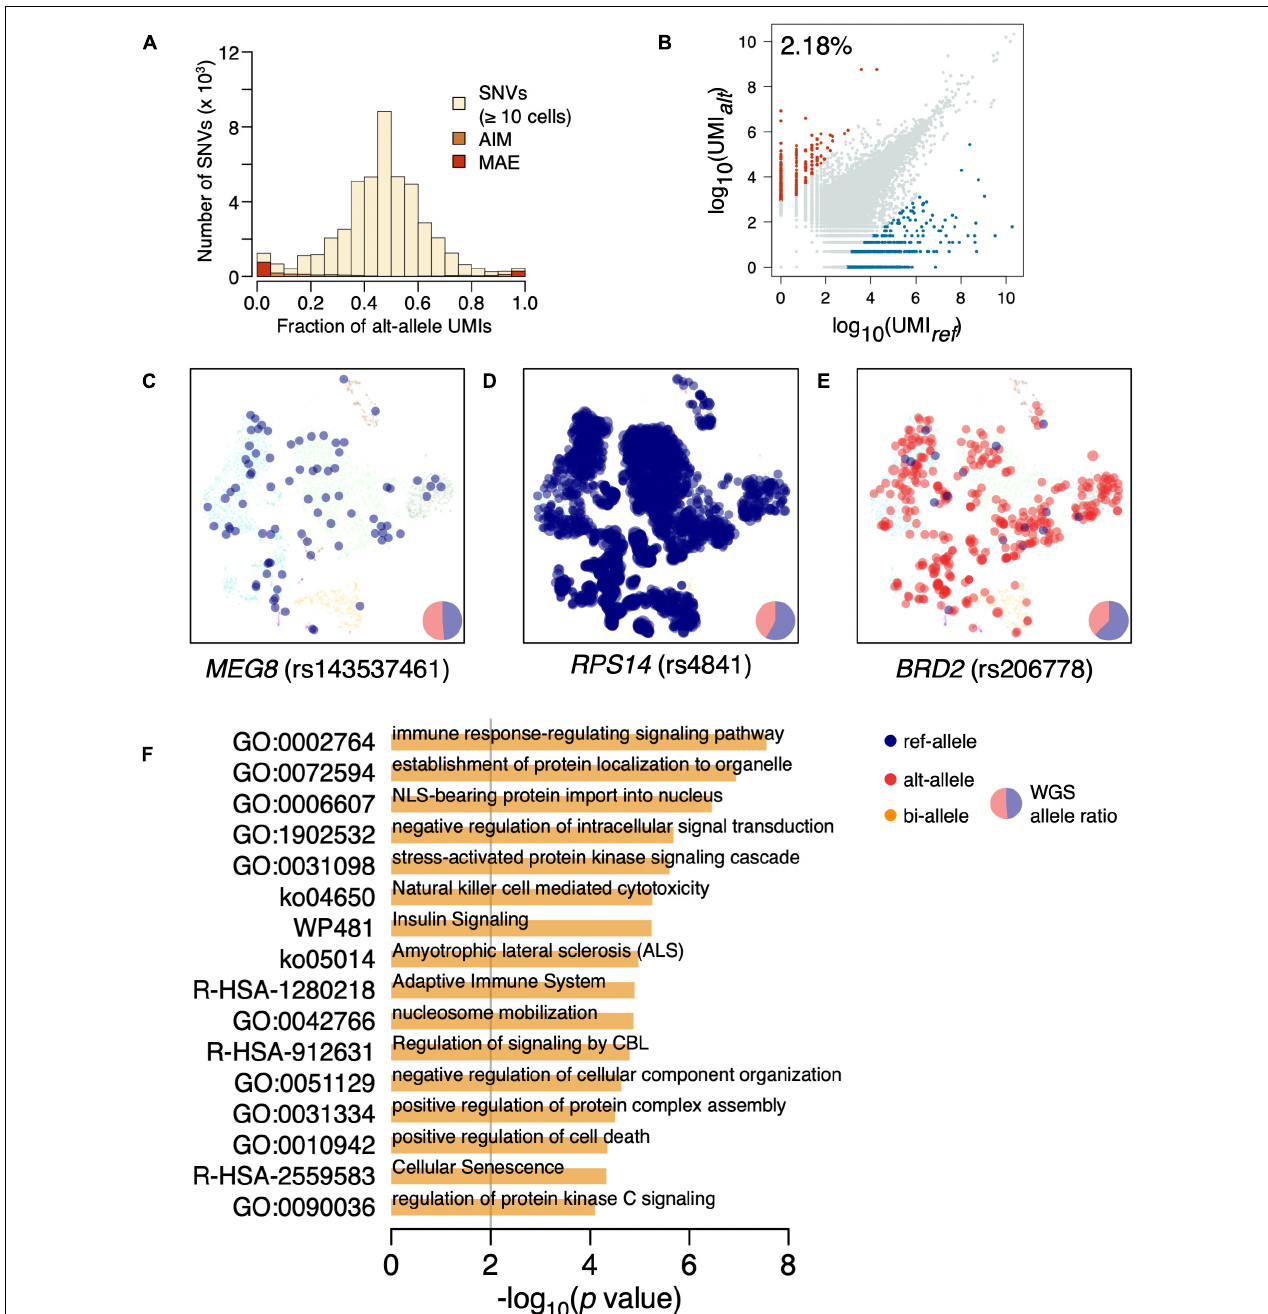
FIGURE 1 | Identification of constitutive MAEs in BMMCs. (A) Histogram of VAF in BMMCs estimated by UMI counts. AIM expression and MAE are highlighted. (B) Identification of constitutive MAEs, with blue representing MAEs of reference allele while red representing MAEs of the alternative allele. The percentage of the constitutive MAE is shown on the top left of the plot. (C) tSNE projection of BMMCs (background), colored by expressed allele of MEG8 . The size of the highlighted dot is scaled to log 10 of UMI count. The pie chart in the bottom right shows the genetic allelic ratio of the two alleles from whole-genome sequencing (WGS) data. (D) tSNE projection of BMMCs, colored by expressed allele of RPS14 . (E) tSNE projection of BMMCs, colored by expressed allele of BRD2 . (F) GO enrichment analysis of the constitutive MAEs in BMMCs.